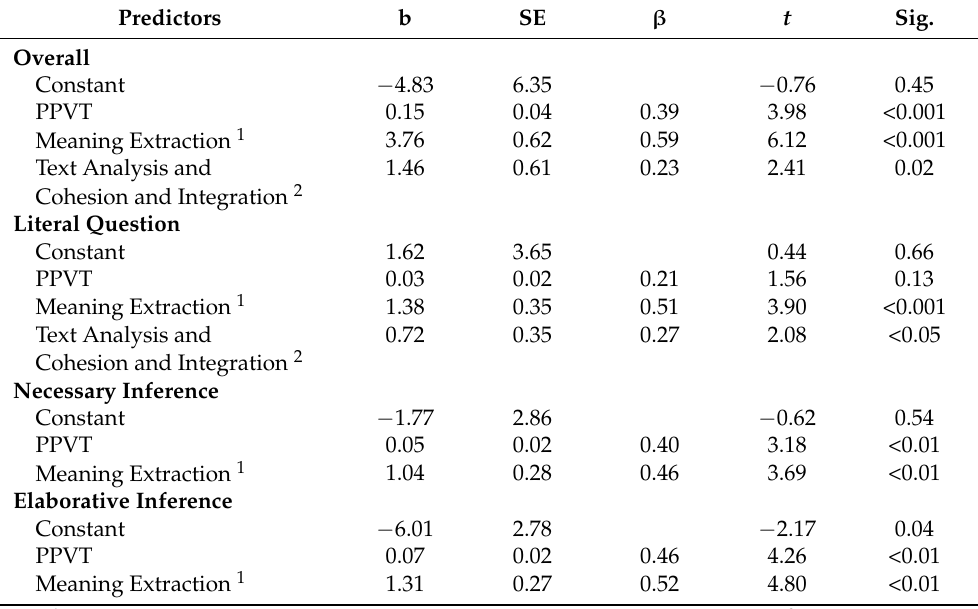
Table 8. Coefficient Table of French Variables That Predict Successful French Reading